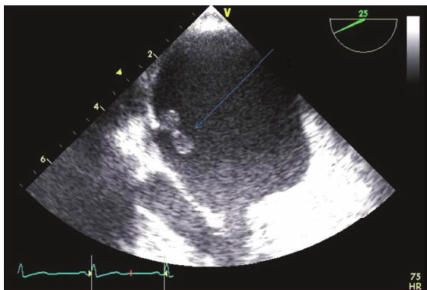
Figure 1: TEE view of thrombus in the left atrium attached to the pin of the Amplatzer septal occluder